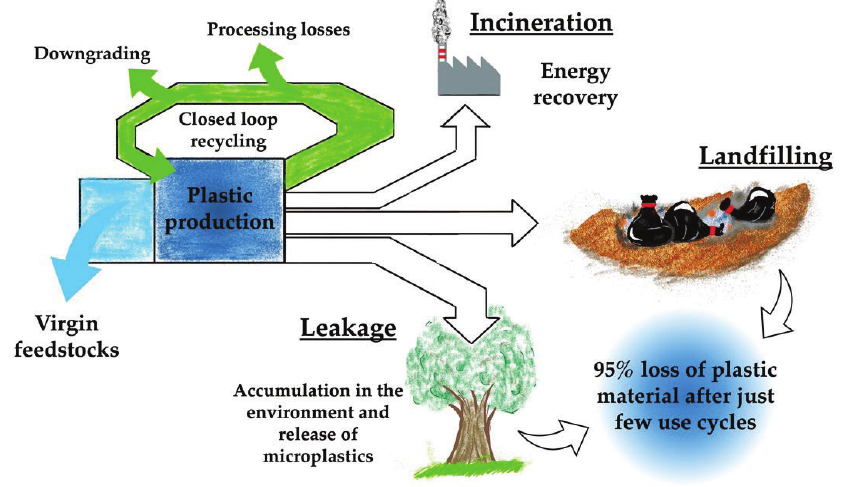
Figure 1. Schematic representation of the life cycle of plastic materials.